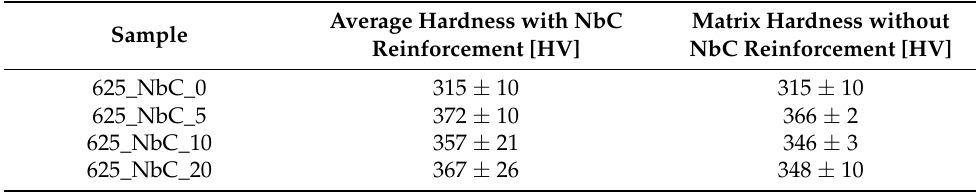
Table 9. Hardness of heat-treated Inconel 625-NbC materials.